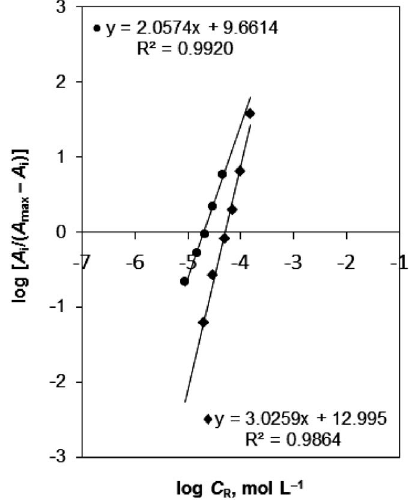
Figure 4. Straight lines by the mobile equilibrium method for deter- mination of the molar ratios Ge(IV):4-NC and Ge(IV):TV; C Ge(IV) = 2.0 × 10 –5 mol L –1 ; pH = 4.0; λ = 420 nm; τ = 2 min; ◆ Ge(IV):4-NC, C TV = 3.0 × 10 –4 mol L –1 ; • Ge(IV):TV, C 4-NC = 5.0 × 10 –4 mol L –1